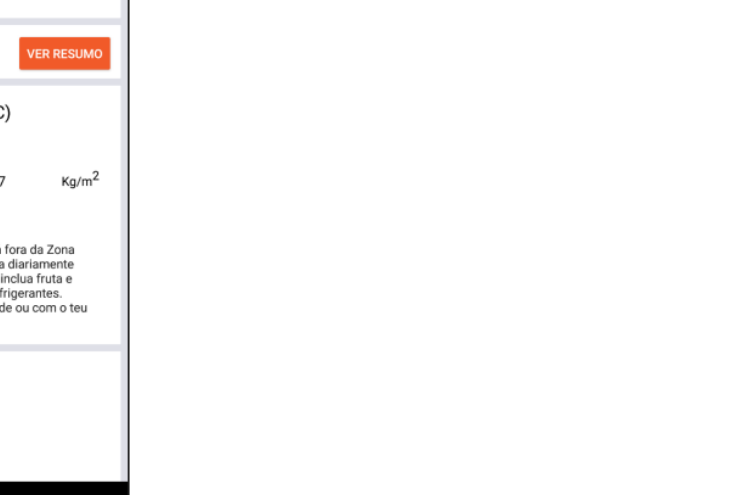
Figure 10. Back button—biomedical data (“dados biom é tricos”) with body mass index (BMI—“índice de massa corporal (IMC)), waist circumference (“perímetro da cintura”)— mental model.